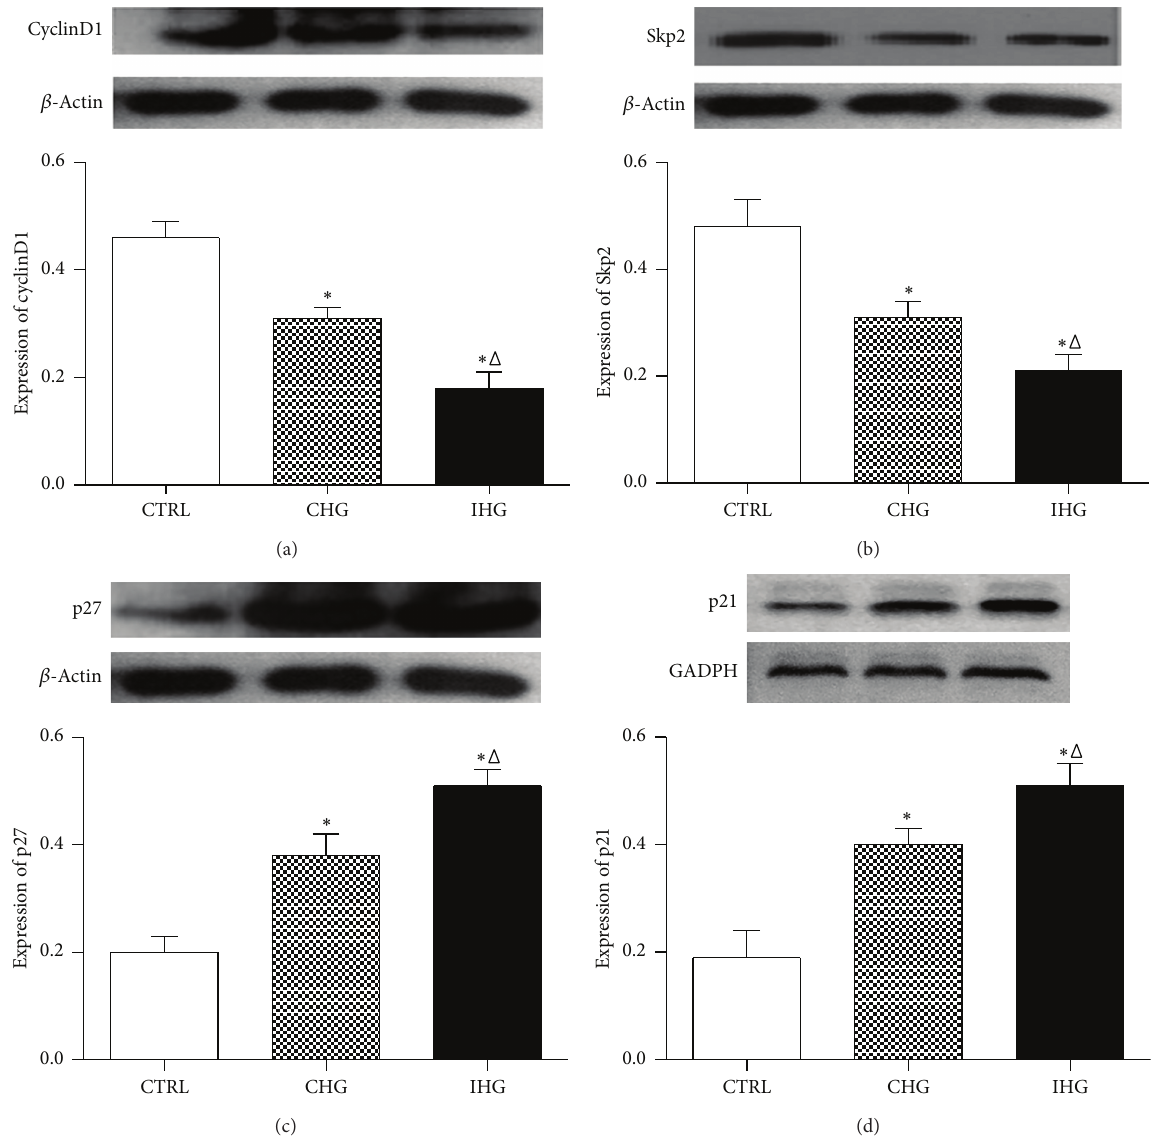
Figure 5: Expressions of cyclinD1, Skp2, p21, and p27 protein level in INS-1 cells were measured by Western blot analyses. Control, normal glucose; CHG, constant high glucose; IHG, intermittent high glucose. Data were expressed as mean ± SD. ∗ 𝑃 < 0.05 and Δ 𝑃 < 0.05 , respectively, indicate a significant difference from controls and